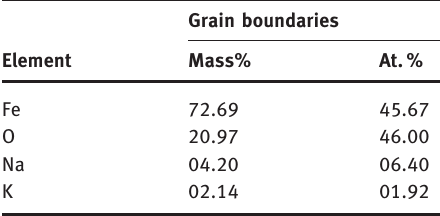
Figure 11: SEM micro- graph showing precipita- tion on substrate areas of the (a) as-received specimen, (b) corrosive specimen at 973.15K/ 100MPa and the (d) spectrum for the pre- cipitation on the grain boundaries of the (c) corrosive specimen at 998.15K/100MPa.